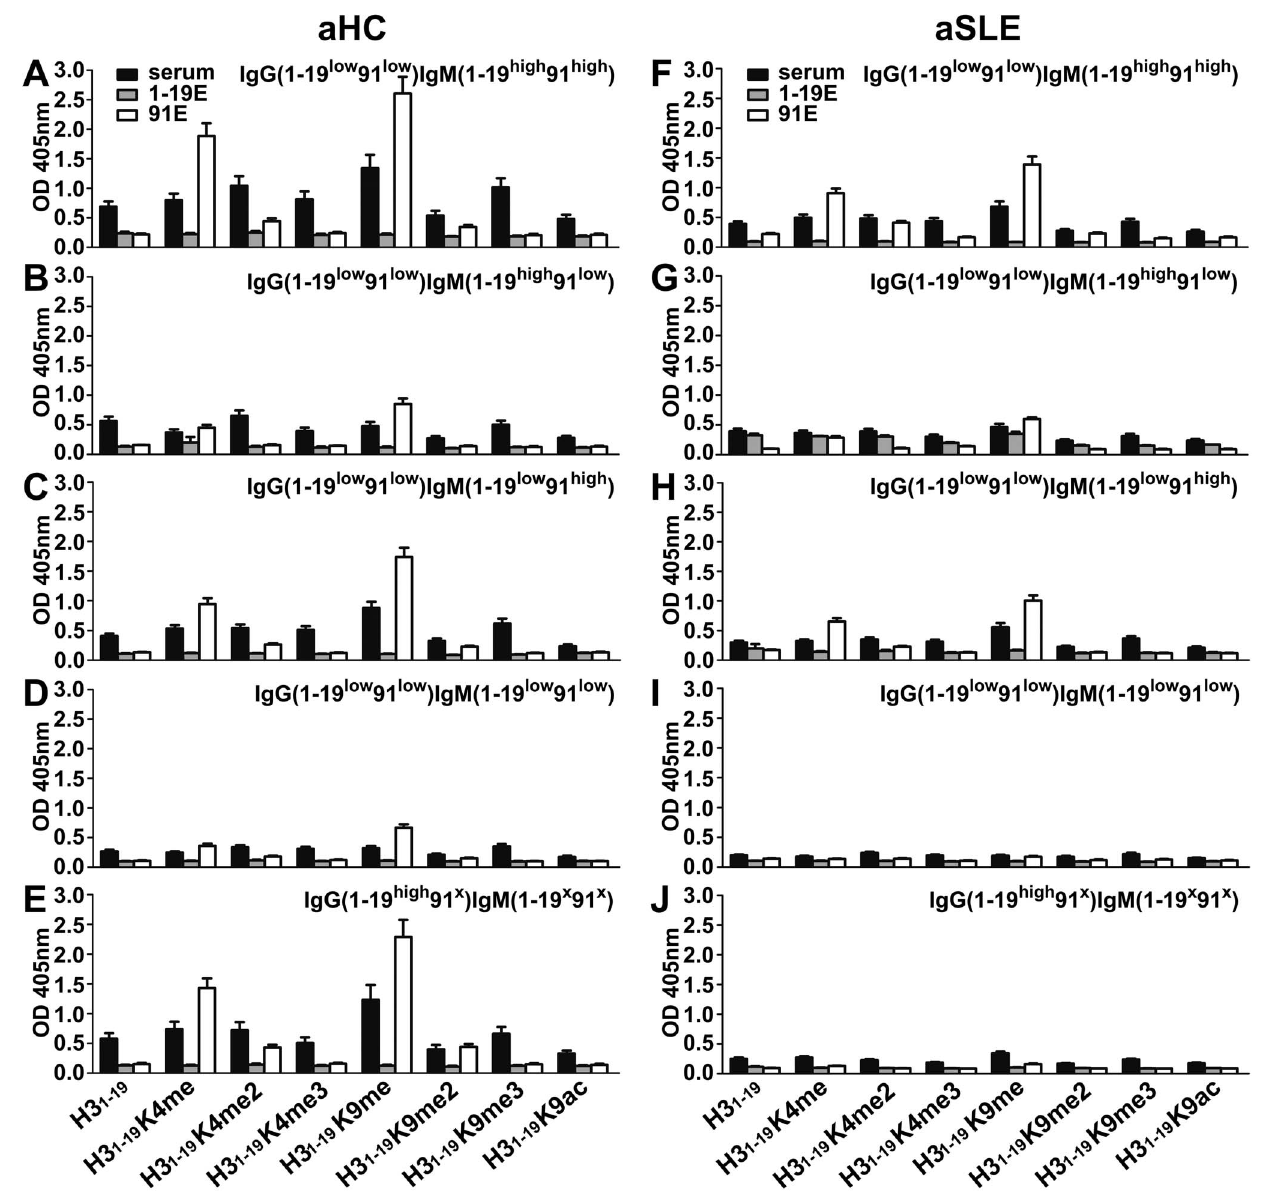
Figure 5. Reactivity of purified IgM against H3 peptides. Equal volumes (1.5 ml) of the pooled serum samples from each subgroup were affinity purified using H3 1–19 and H3 1–19 K9me beads in tandem (see Materials and Methods). Microtiter plates were coated with various peptides conjugated to BSA as indicated. Eluates from the H3 1–19 and H3 1–19 K9me beads were separately tested for their reactivity against the peptides. KT16 anti-human IgM was used as the primary Ab and HRP-conjugated goat anti-mouse IgG was used as the secondary Ab. The samples were tested in duplicate. 1–19E, Abs eluted from the H3 1–19 beads; 91E, Abs eluted from the H3 1–19 K9me beads. Data are expressed as mean + SEM. The results are representative of two independent